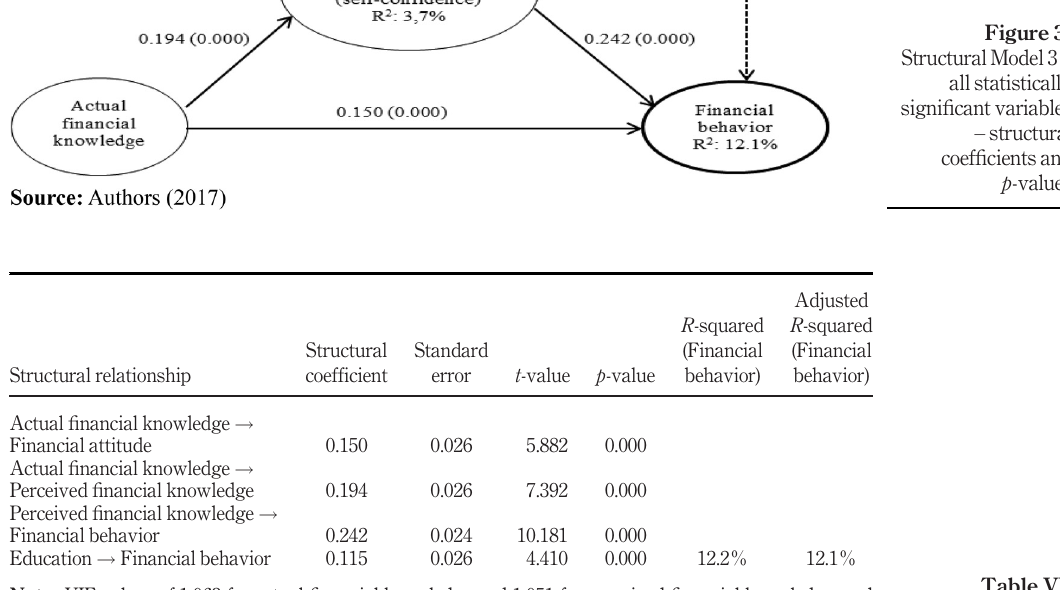
Figure 3. Structural Model 3